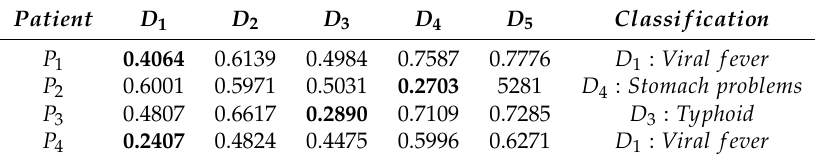
Table 8. The results generated by the proposed method in Example 4.